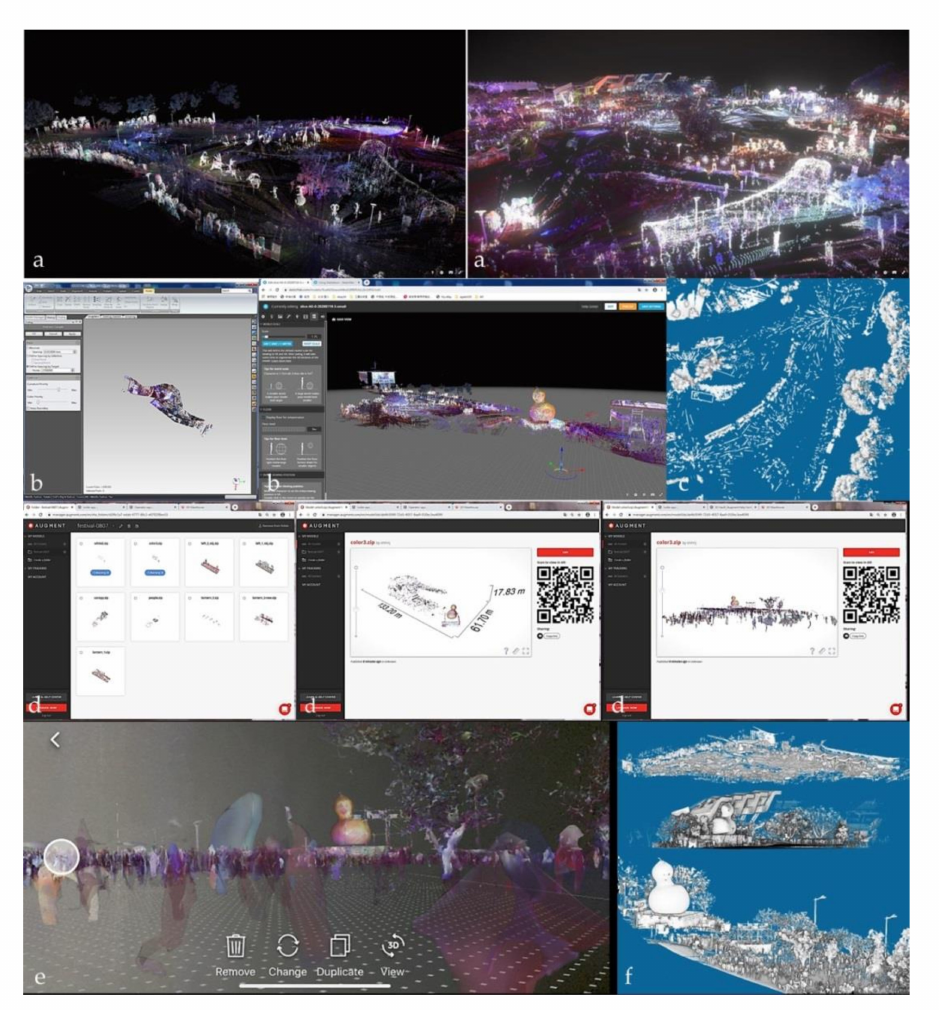
Figure 7. ( a ) Screen shots of the Sketchfab ® app in browse and virtual reality (VR) mode; ( b ) converting process for decimation and model setting; ( c ) a full resolution with the silhouettes of crowds identifiable when a small part was presented; ( d ) the Augment models; ( e ) the decimated mesh model in Augment ® ; ( f ) the point cloud model in Meshlab ®